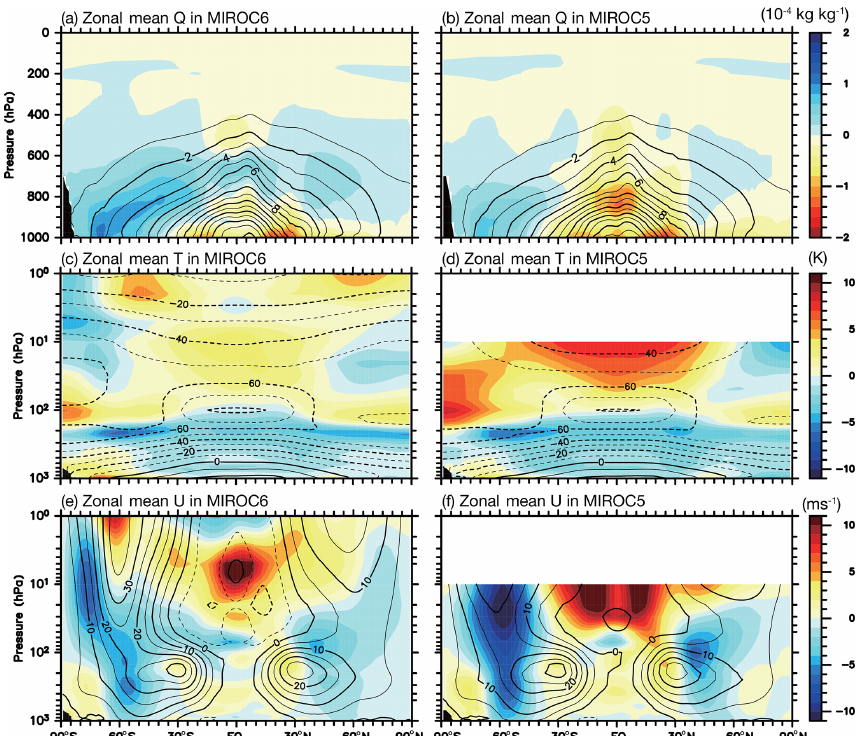
Figure 7. Annual and zonal mean specific humidity (a, b) , temperature (c, d) , and zonal wind (e, f) in MIROC6 (a, c, e) and MIROC5 (b, d, f) . Colors indicate errors with respect to observations (ERA-I) and contours denote values in each